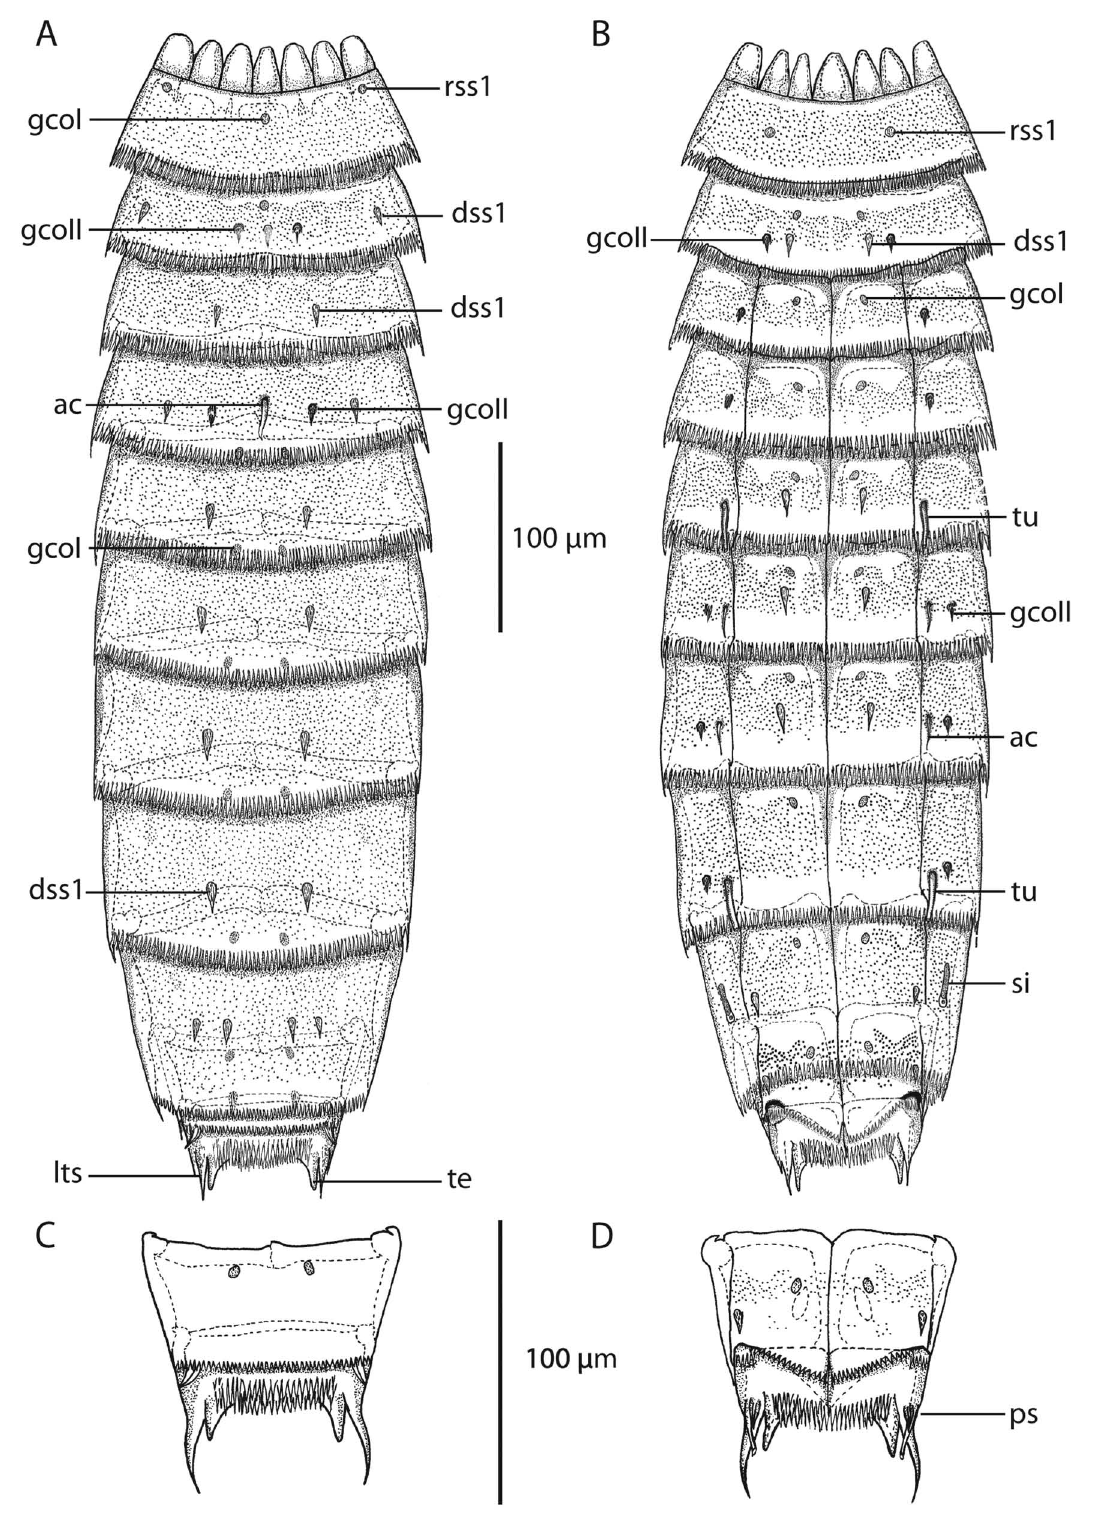
Fig . 3. – Line art illustrations of Echinoderes rex n. sp. A, female, dorsal view; B, female, ventral view; C, male, segments 10 and 11, dorsal view; D, male, segments 10 and 11, ventral view. Abbreviations: ac, acicular spine; dss1, droplet shaped sensory spot type 1; gcoI, glandular cell outlet type I; gcoII, modified glandular cell outlet type II; lts, lateral terminal spine; ps, penile spines; rss1, rounded sensory spots type 1; si, sieve plate; te, tergal extension; tu,